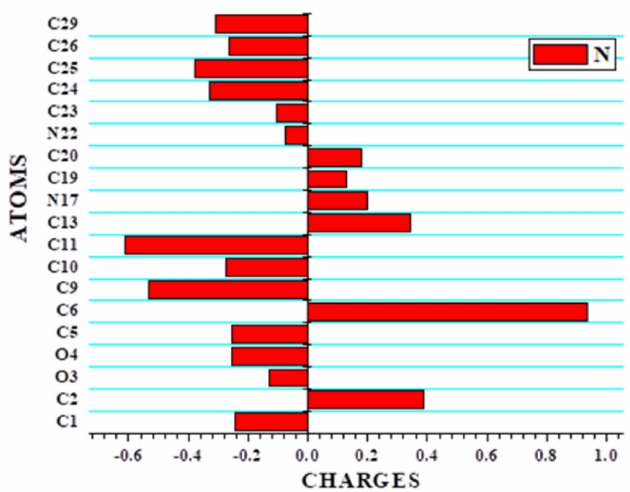
Figure 6. The histogram of calculated Mulliken charge of